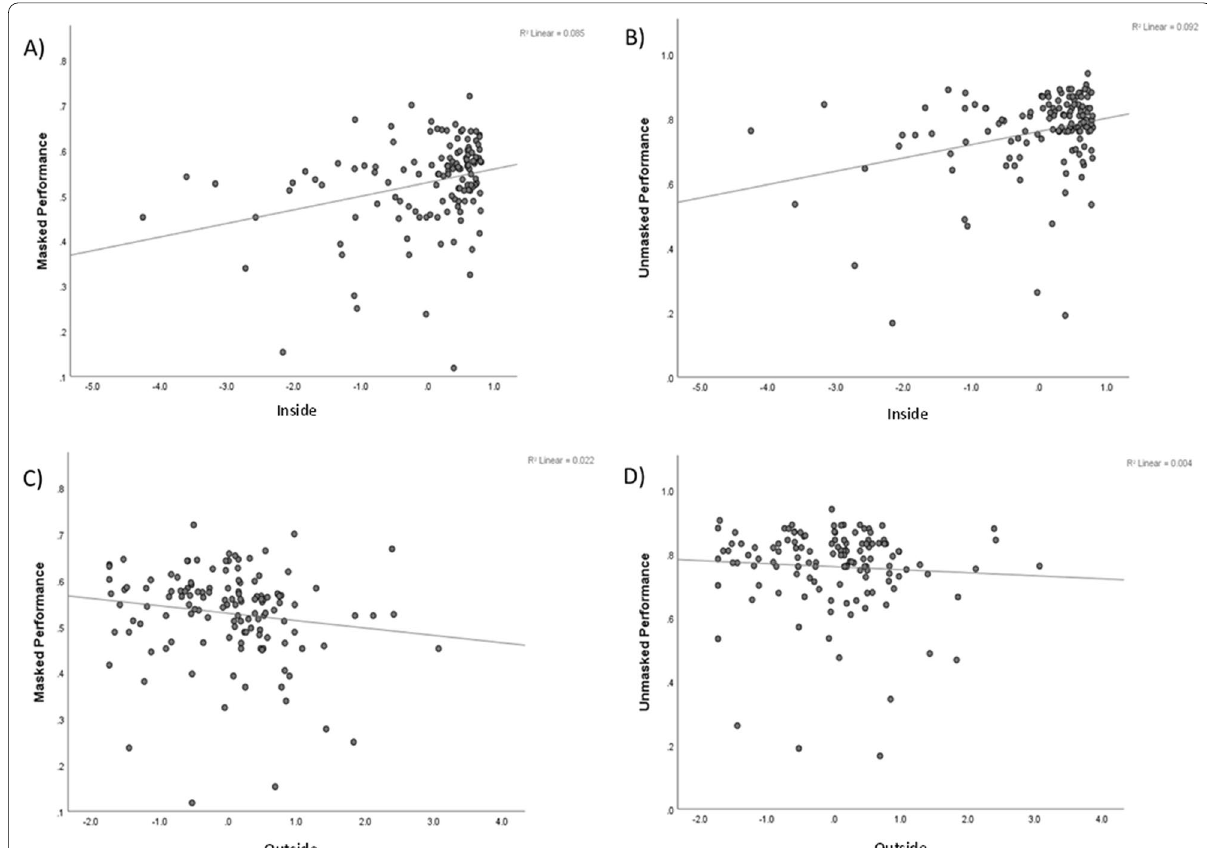
Fig. 4 Scatter graphs showing the correlation between the components and masked or unmasked emotion recognition performance: A Inside and masked performance. B Inside and unmasked performance. C Outside and masked performance. D Outside and unmasked